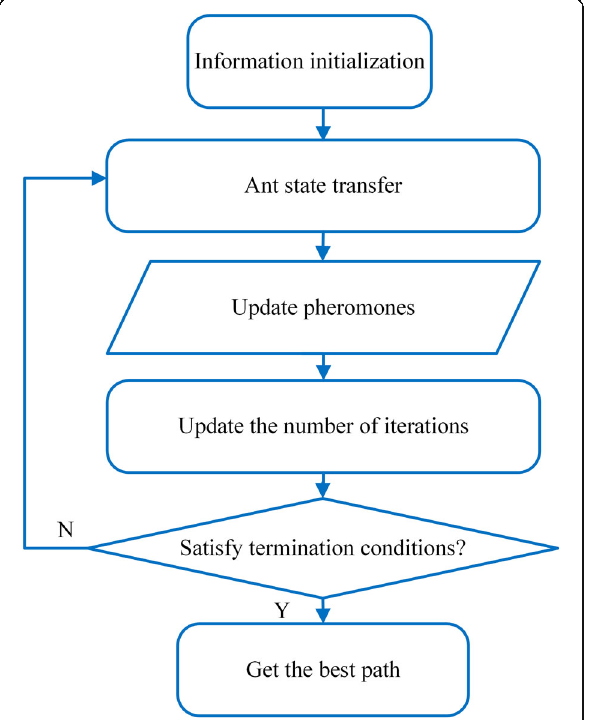
Fig. 4 The flow chart of ant colony